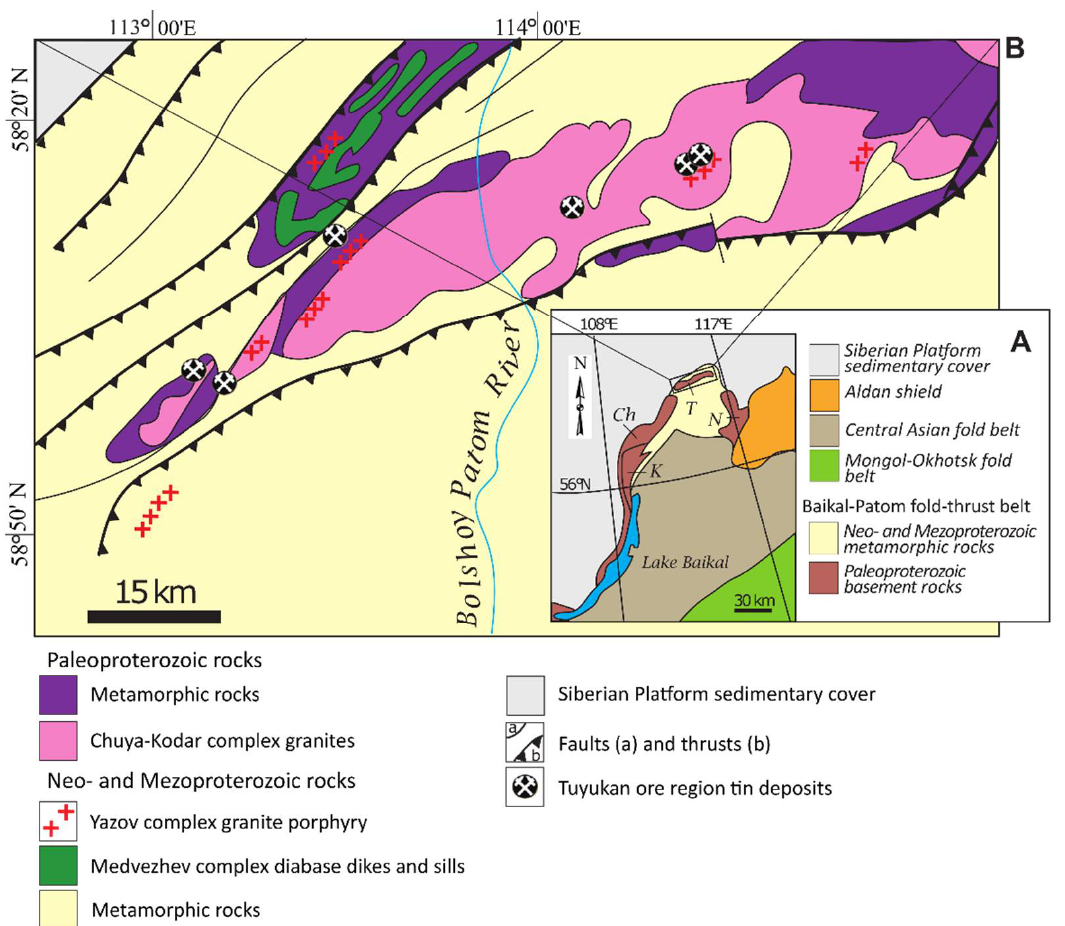
Figure 3. Regional geological map ( A ) and locations of the Yazov and Chuya-Kodar granites and ore metasomatites sampling sites for U-Pb geochronology ( B ) Uplifted Paleoproterozoic rocks: Ch—Chuya uplift, K—Kutim uplift, T—Tonod uplift, and N—Necher uplift. Symbols of the Yazov complex granite porphyry and Tuyukan ore region tin deposits are not to scale (modified from Neymark et al. [16]).